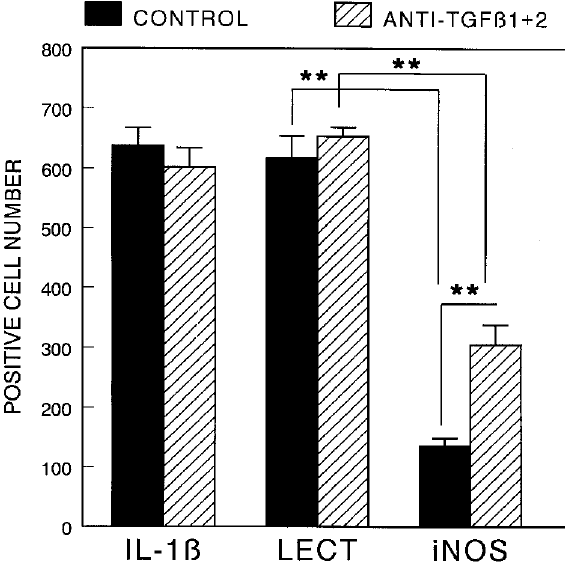
FIG. 5. Effect of immunoneutralizing of TGF b 1 and TGF b 2 on endotoxin induced expression of IL-1 b and iNOS by con- fluent mixed glial cell cultures containing mainly astroglial cells and microglial cells. Numbers of immunopositive cells in 24h endotoxin (1 m g/ml) stimulated mixed glial cell cultures. Different cultures were stained with the microglial cell marker GSA-l-B4-isolectin (LECT) or for IL-1 b or iNOS. Data are expressed as the mean and SE ( n = 3). ** P <